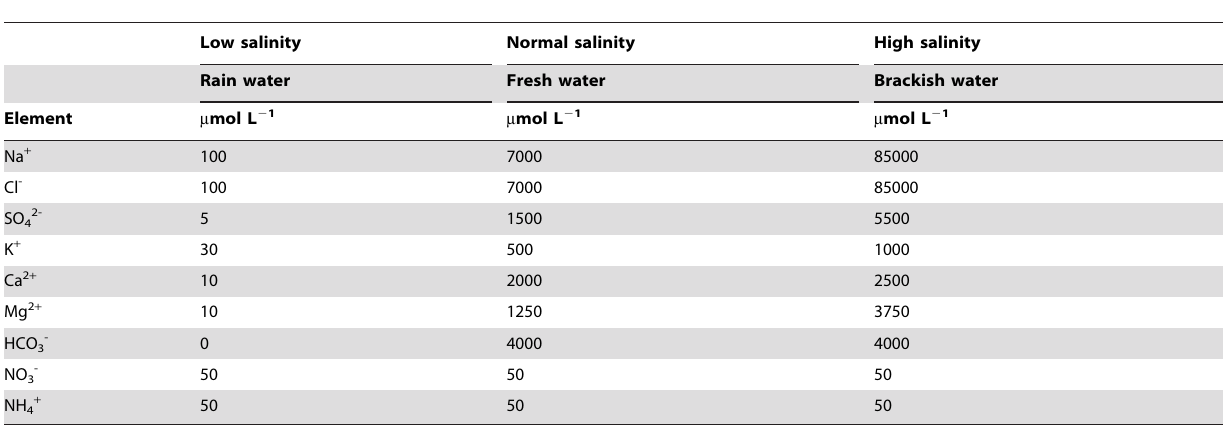
Table 2. Chemical composition of the surface water used for the different treatments (low, normal or high